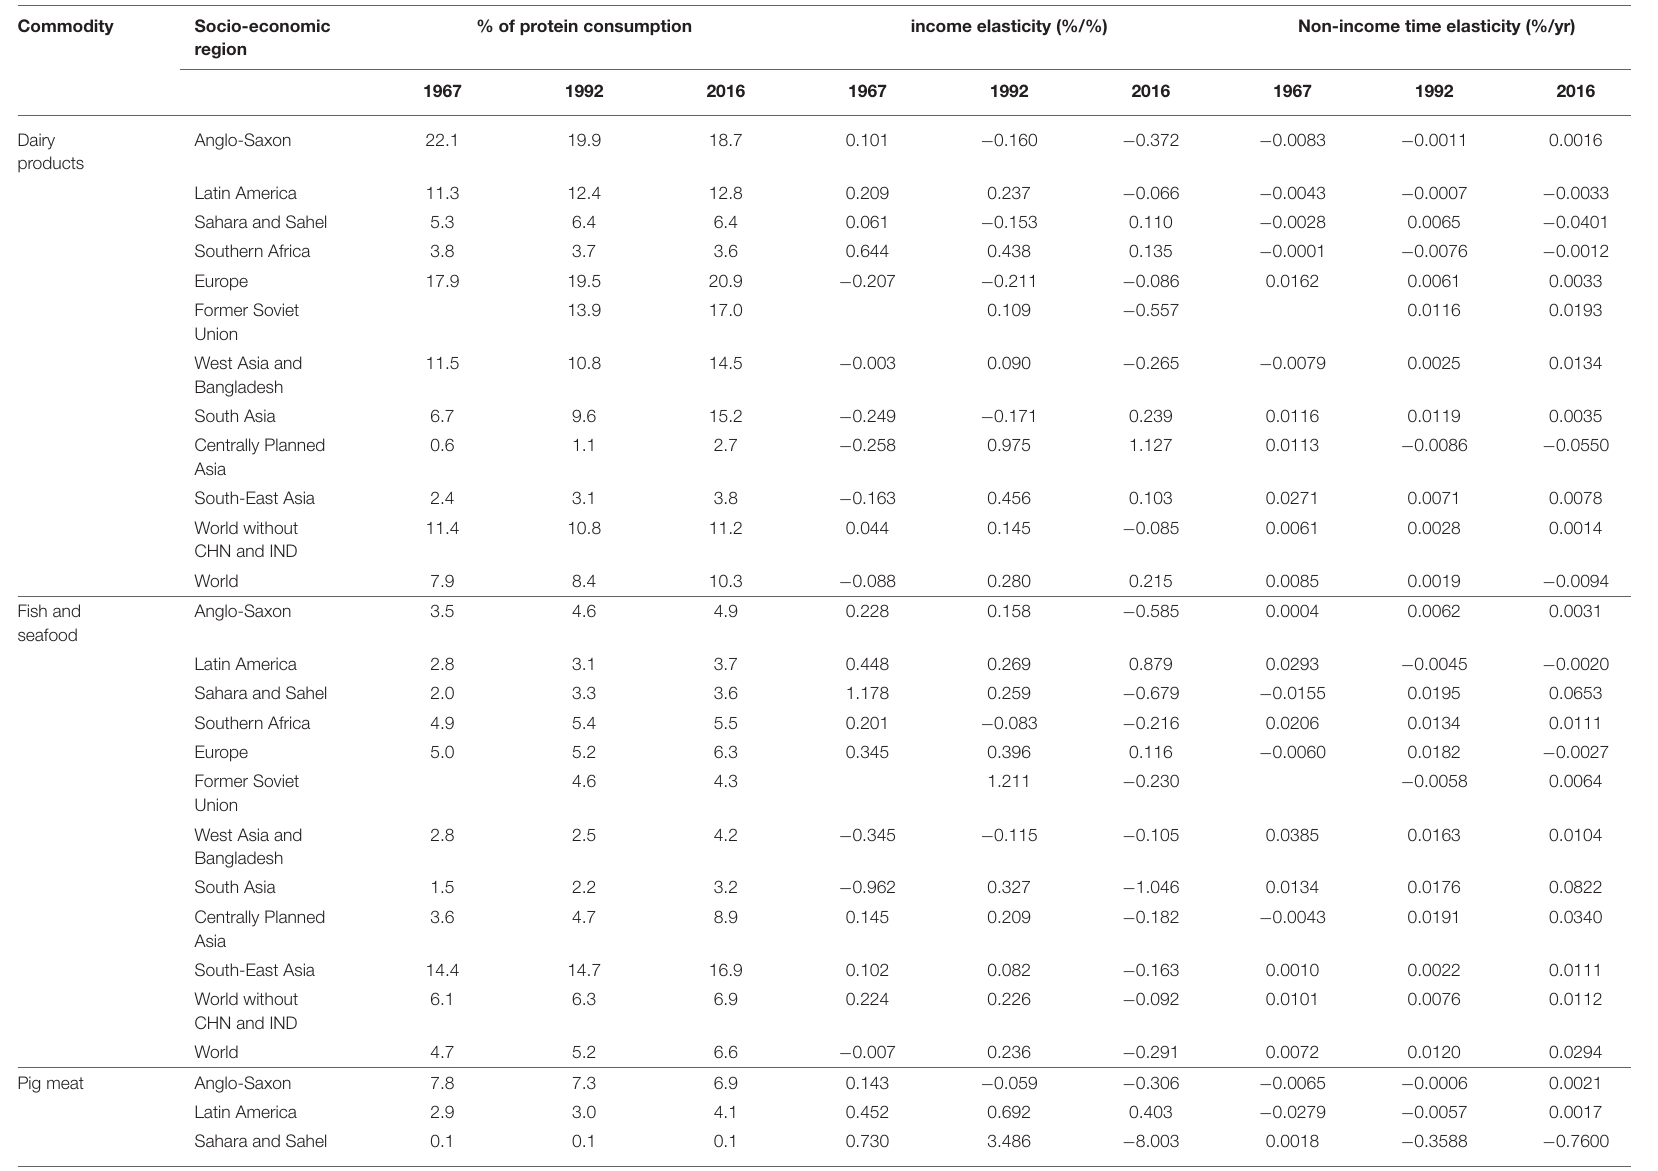
TABLE 3 | Time trends of the contributions made to protein consumption by animal source food commodities, and of their estimated income elasticities ( β ) and non-income time elasticities ( γ ). CHN: China, IND: